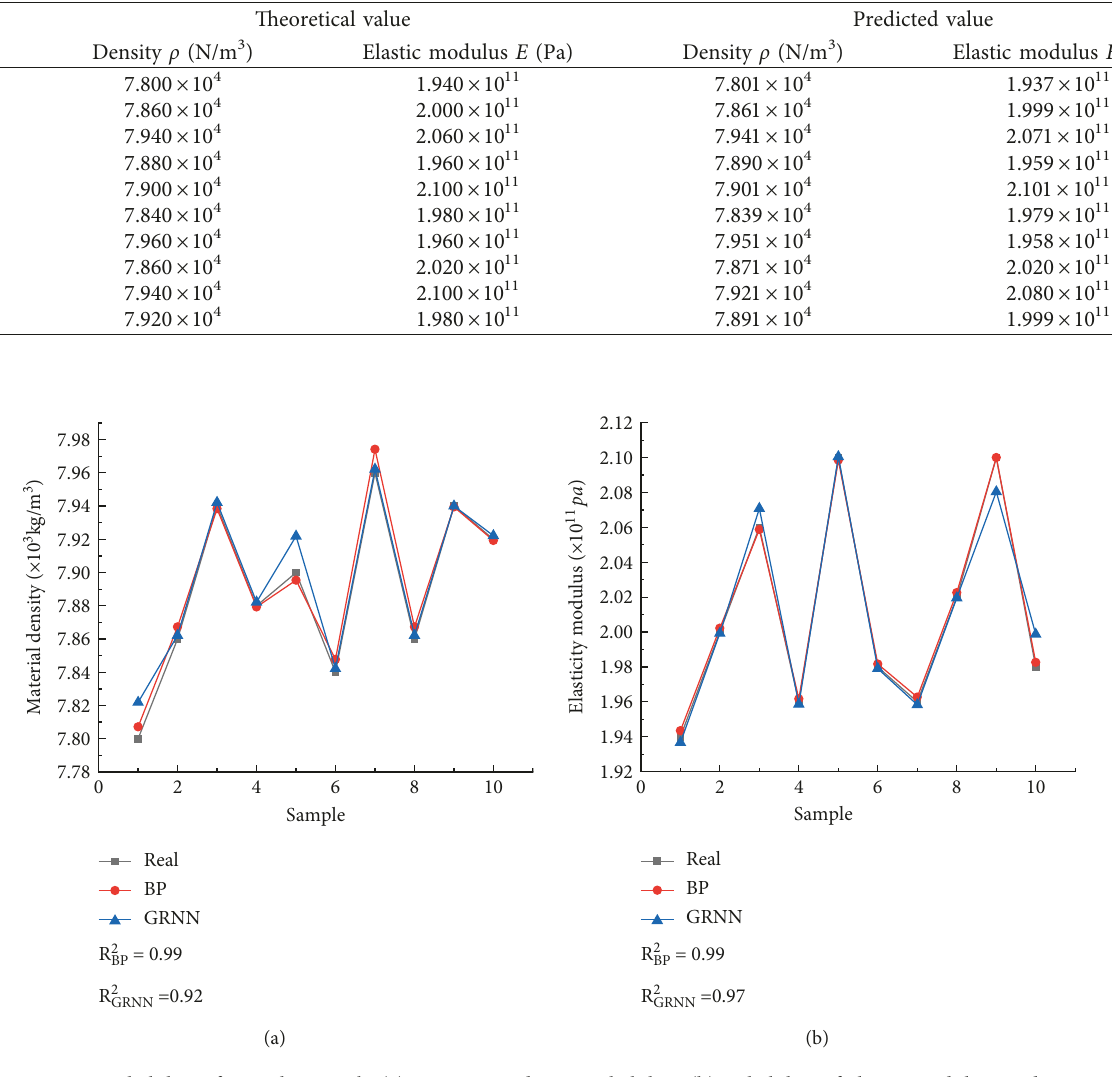
Figure 10: Reliability of neural network. (a) Density prediction reliability. (b) Reliability of elastic modulus